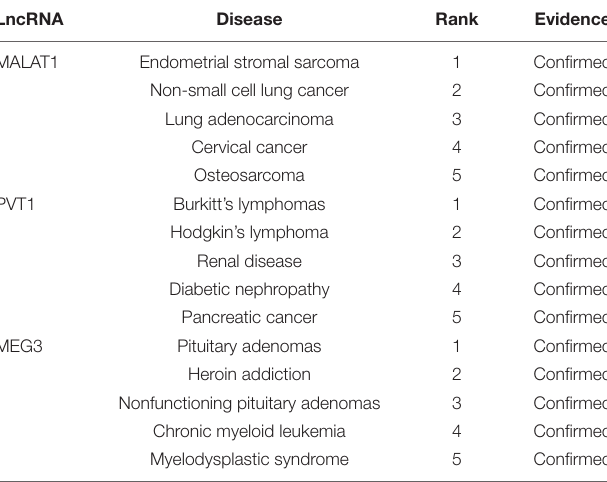
FIGURE 3 | The PR curves of MHRWRLDA, KATZLDA, BPLLDA, and LRLSLDA based on global LOOCV.